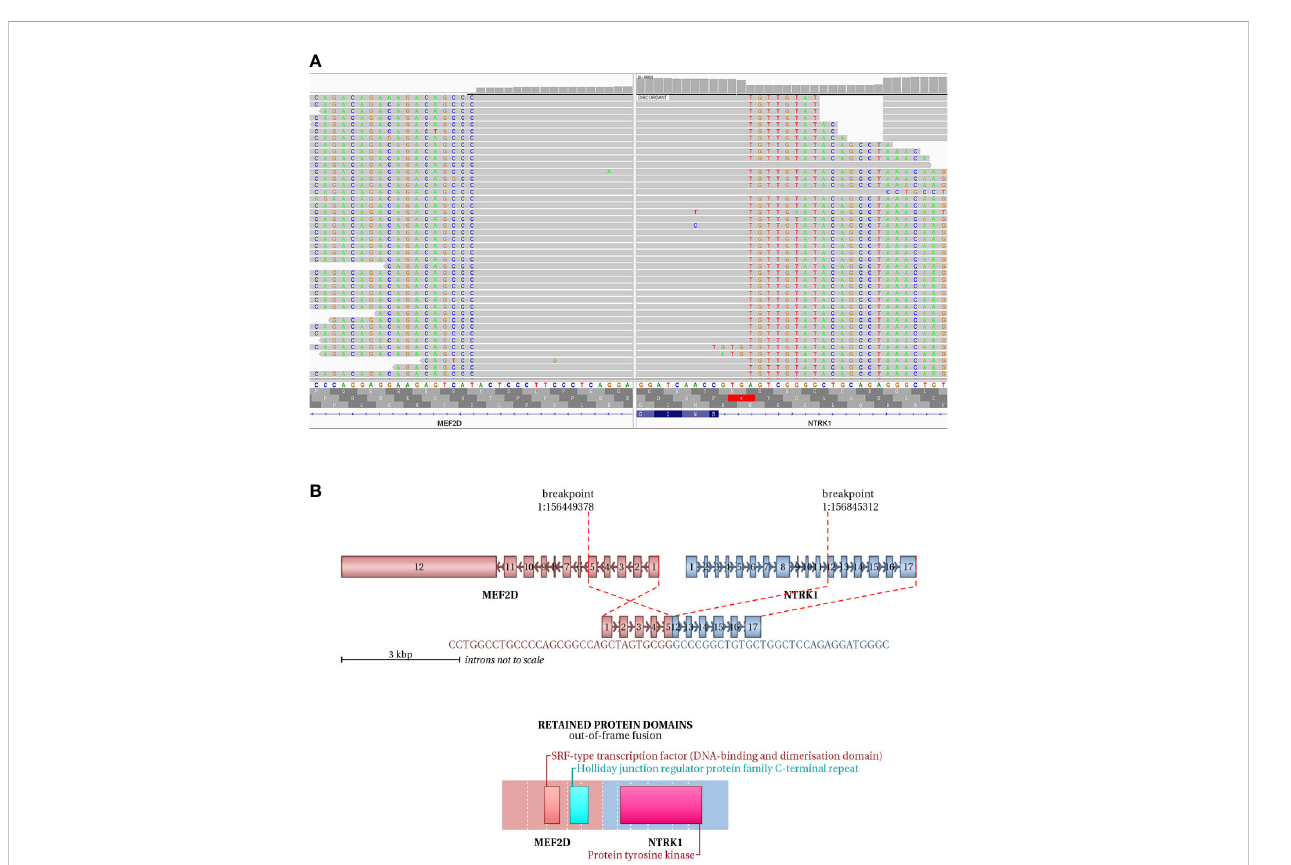
FIGURE 3 NGS testing of the tumor to validate NTRK1 fusion. (A) DNA-based NGS testing of the pan-tumor related 1021-Genes Panel is used to demonstrate the MEF2D-NTRK1 (EX5:EX12) fusion in formalin- fi xed paraf fi n-embedded tissue sample. (B) Schematic representation of the predicted chimeric protein in RNA-based NGS assay with the 555-Genes Panel in formalin- fi xed paraf fi n-embedded tissue